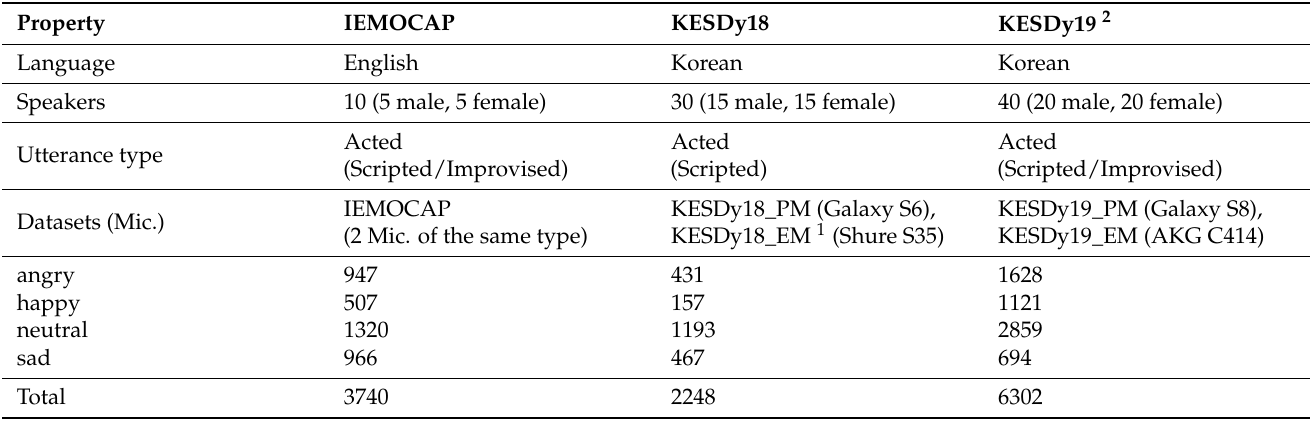
Table 2. Properties of multi-domain SER